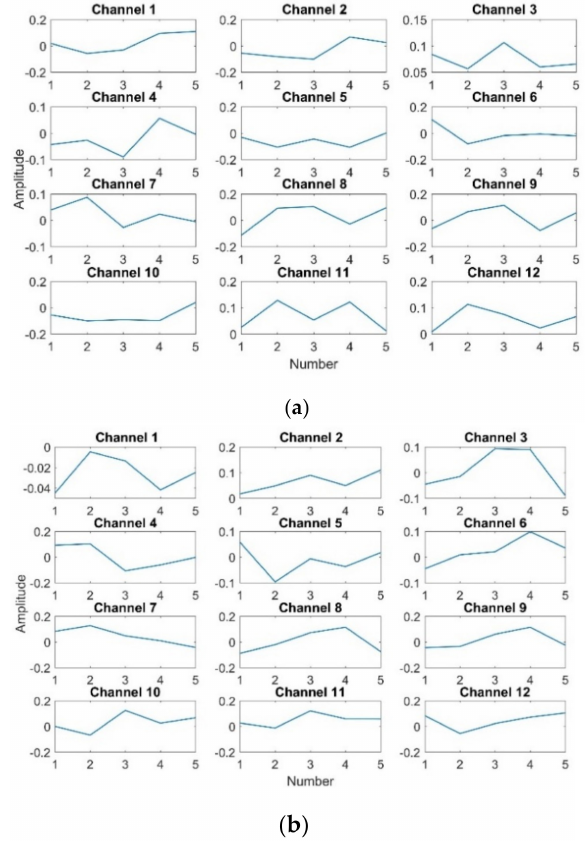
Figure 15. The curve of the first twelve channels. ( a ) Kernel 1 ( b ) Kernel 2.